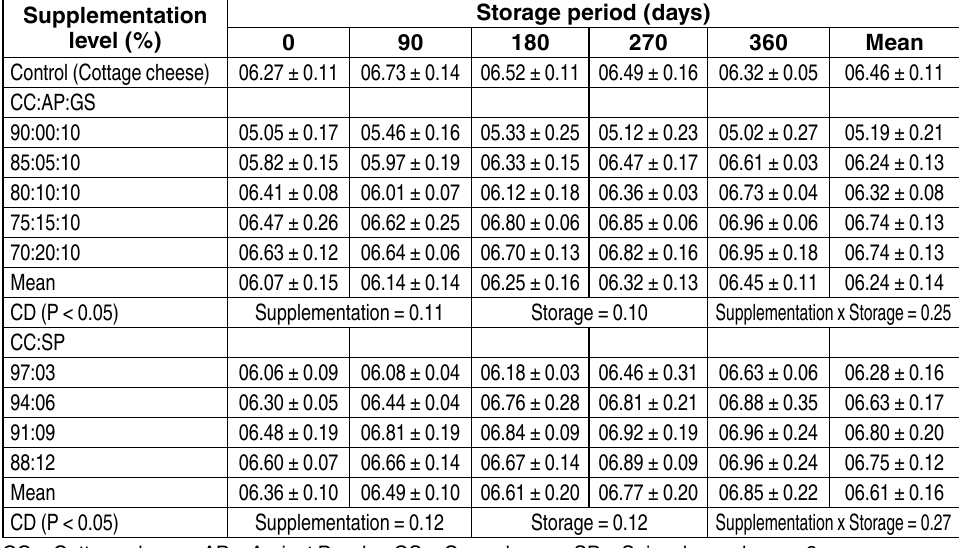
Table 6. Effect of supplementation and storage on titratable acidity of value-added churpe products (balls and